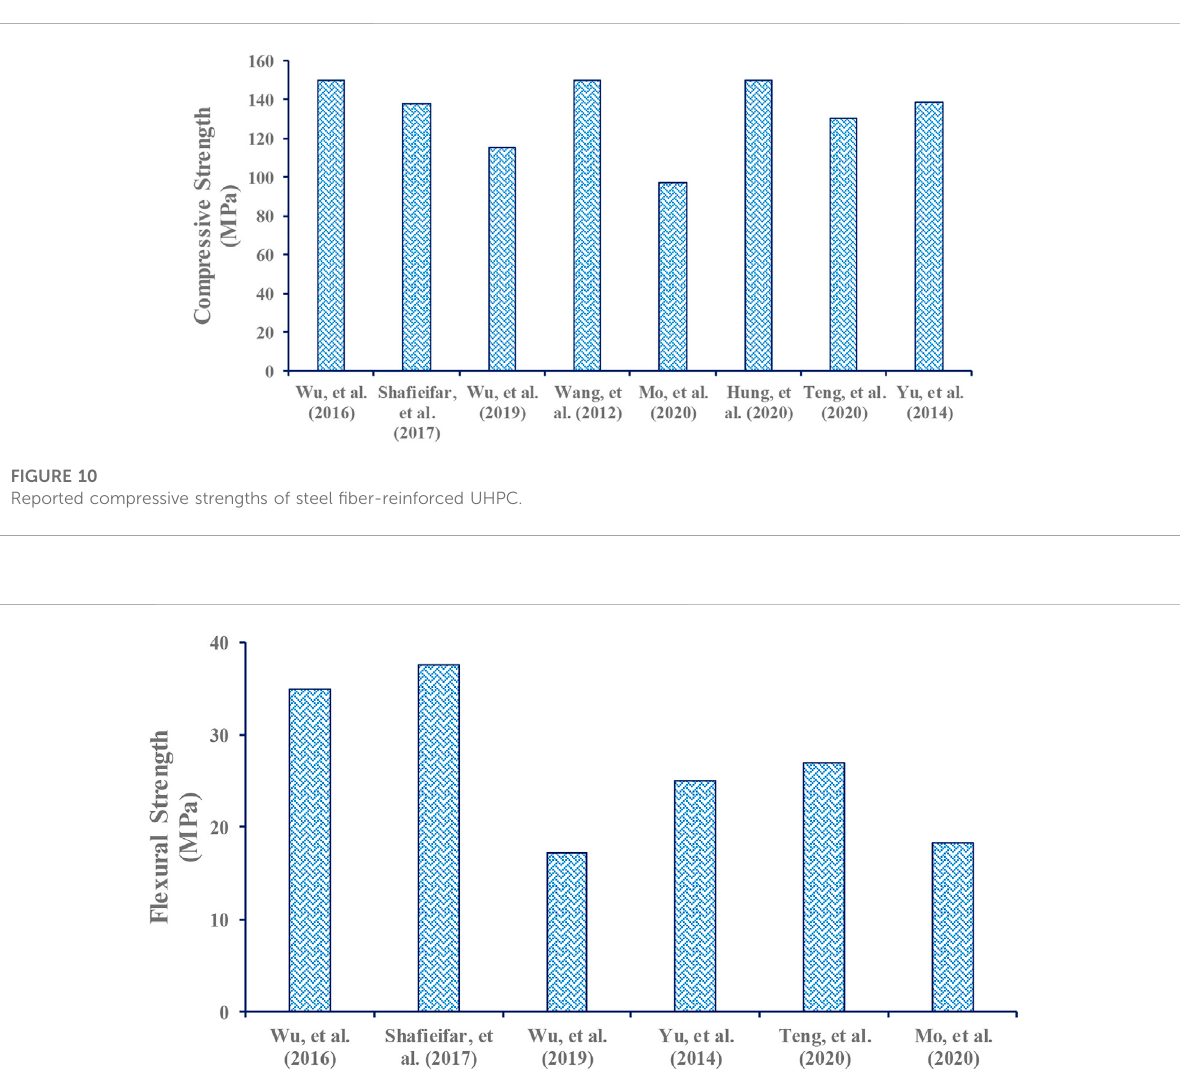
FIGURE 11 Reported fl exural strengths of steel fi ber-reinforced